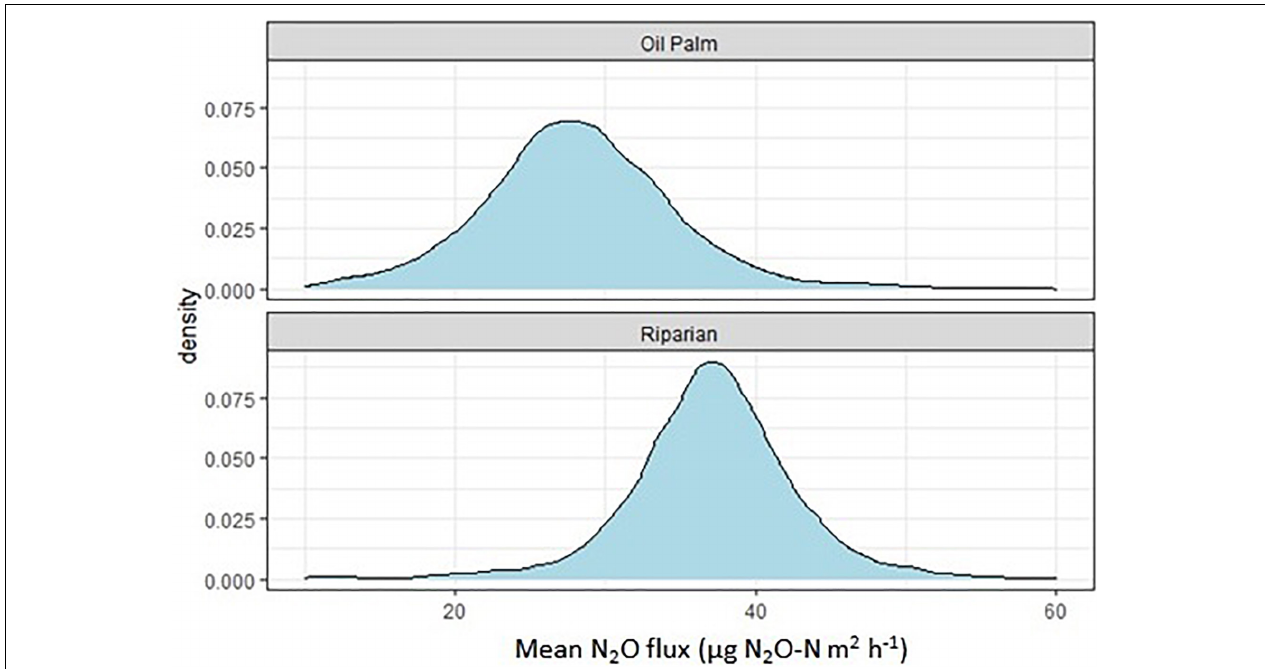
FIGURE 5 | Posterior probability density of the mean nitrous oxide flux from each land-use (oil palm, riparian forest), estimated by the Bayesian generalized linear mixed-effect model (GLMM).